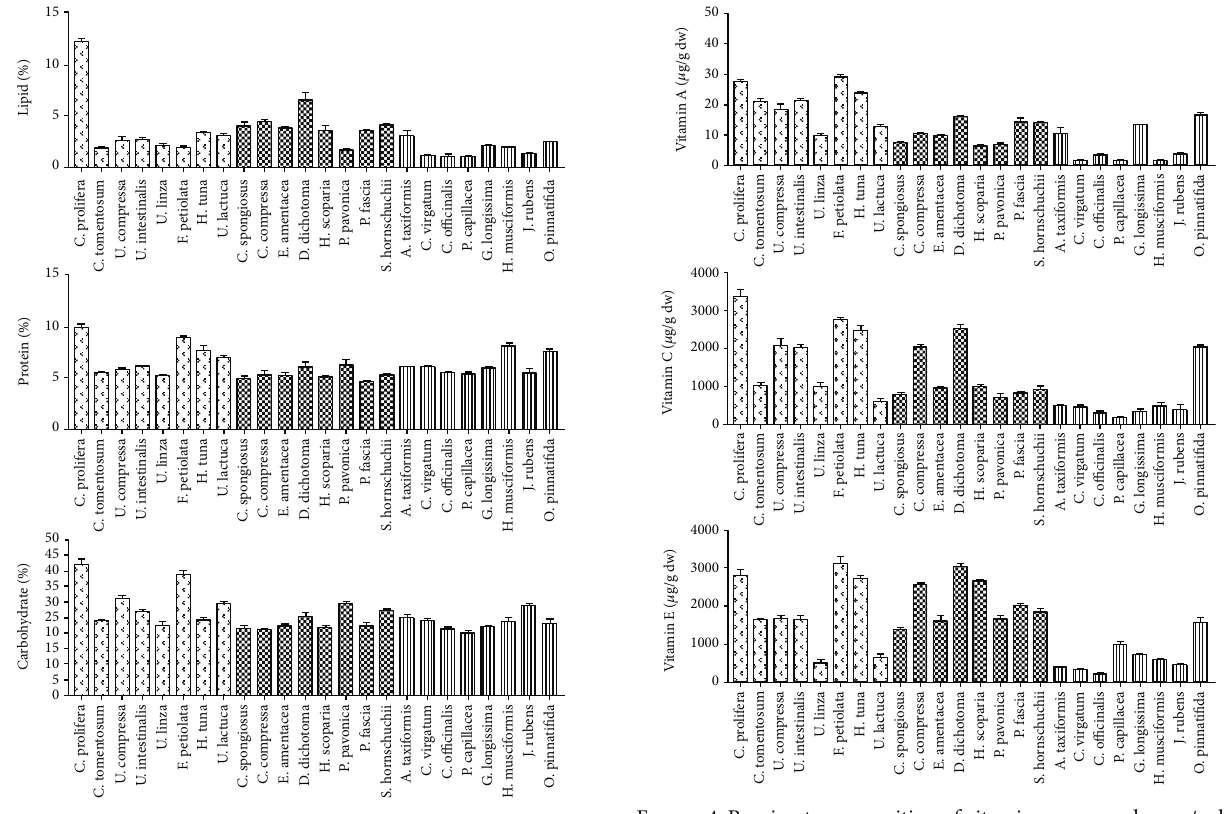
Figure 3: Proximate composition of proteins, fats, and carbohydrates expressed as percentage (%) of seaweeds collected from the Tripoli coastline.